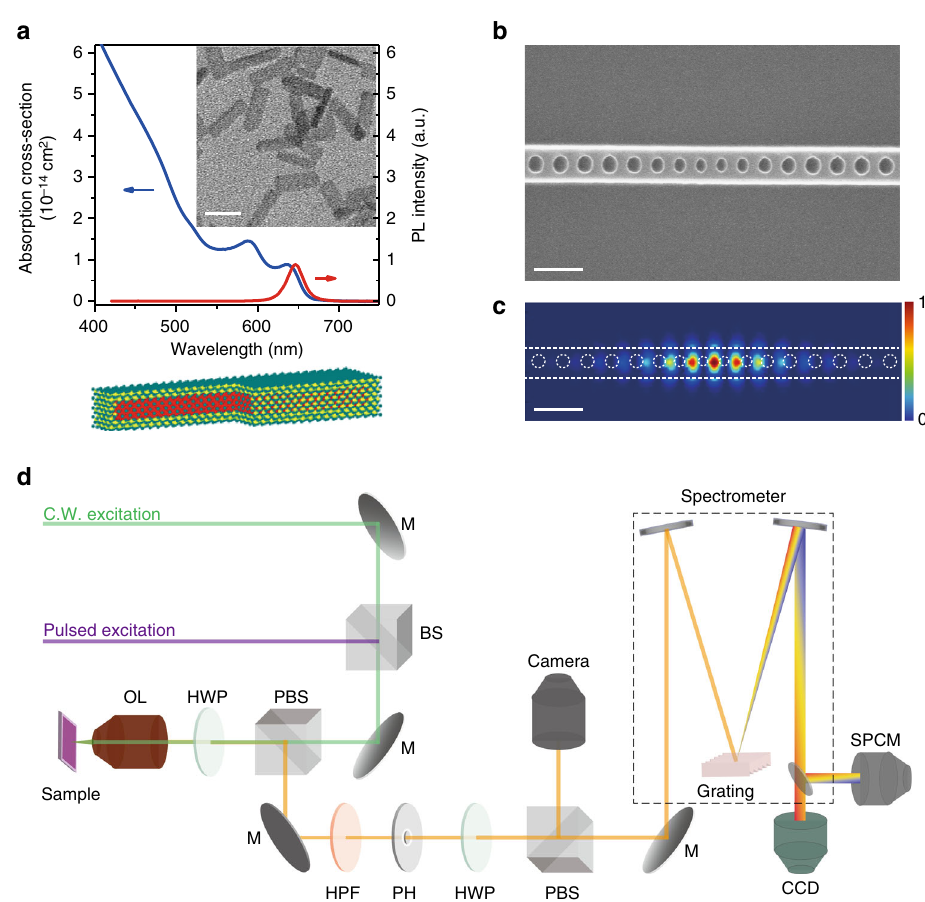
Fig. 1 Design of the nanoplatelet nanolaser. a Absorption cross-section ( blue ) and photoluminescence ( red ) spectra of CdSe core / CdS shell nanoplatelets in solution. The inset shows a transmission-electron-microscope image of nanoplatelets, and the schematic below is an illustration of the nanoplatelet structure. Scale bar is 20 nm. b Scanning electron microscope image of a Silicon nitride photonic-crystal nanobeam cavity before deposition of the nanoplatelets. c Calculated electric- fi eld intensity pro fi le ( | E | 2 ) of the fundamental mode in the cavity. Scale bars in both b and c are 500 nm. d Experimental setup. M: mirror, BS: beam spliter, PBS: polarizing beam spliter, HWP: half-wave plate, OL: objective lens, HPF: high-pass fi lter (cut-off at 600 nm), PH: pin hole as spatial fi ter, SPCM: single photon counting